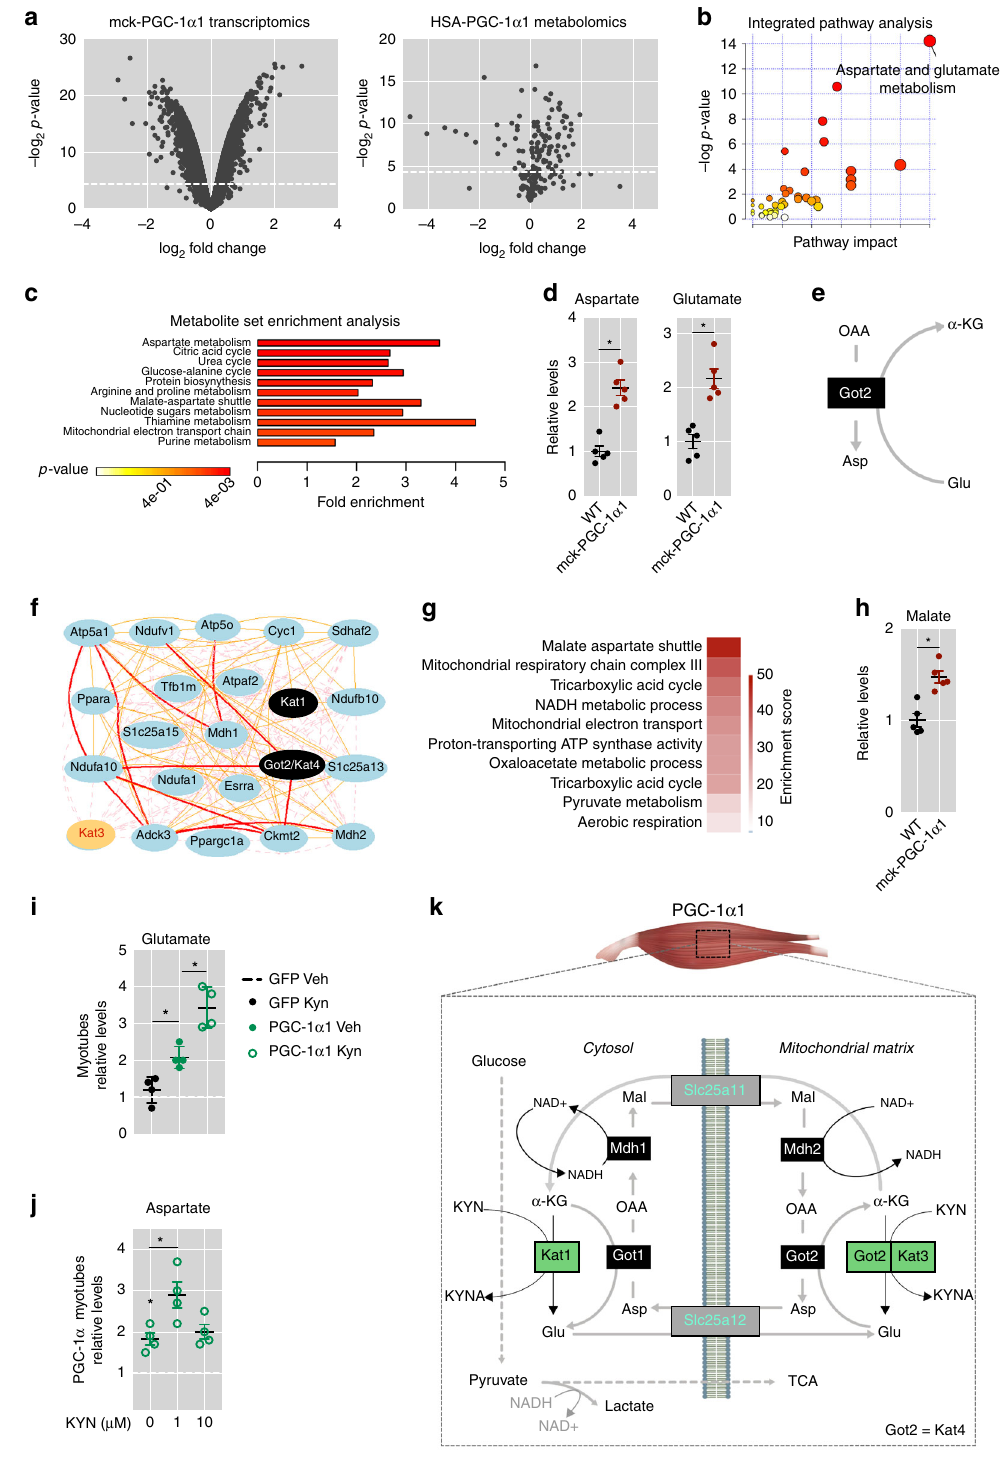
Fig. 1 Regulatory hubs under PGC-1 α 1 control in skeletal muscle. a Transcriptomics and metabolomics analysis of mck-PGC-1 α 1 skeletal muscle. b Integrated pathway analysis of mck-PGC-1 α 1 transcriptomics and metabolomics. c Metabolite enrichment analysis of mck-PGC-1 α 1. d Relative levels of aspartate and glutamate in skeletal muscle of wt and mck-PGC-1 α 1 mice ( n = 5). e Schematic representation of the role of GOT2 in aspartate synthesis. f Overlapping Kat -associated networks. g Functional annotation of the Kat -associated network. h Relative levels of malate in skeletal muscle of wt and mck- PGC-1 α 1 mice ( n = 5). i Relative levels of glutamate in primary myotubes transduced with Gfp control or Pgc-1 α 1 adenovirus and supplemented with 1 μ M kynurenine (Kyn) ( n = 4) j Relative levels of aspartate in primary myotubes transduced with Pgc-1 α 1 adenovirus treated with 0, 1 or 10 μ M Kyn ( n = 4). k Schematic representation of how skeletal muscle PGC-1 α 1 integrates Kyn metabolism with aspartate biosynthesis and the malate-aspartate shuttle. Bars depict mean values and error bars indicate SEM. Unpaired, two-tailed student ’ s t -test was used when two groups were compared, and one-way analysis of variance (ANOVA) followed by Fisher ’ s least signi fi cance difference (LSD) test for post hoc comparisons were used to compare multiple groups, * p < 0.05